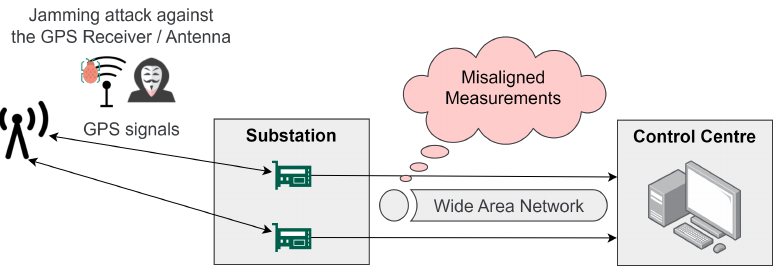
Figure 4. Example of a jamming attack on the GPS signal, which causes misaligned measurements to arrive at the control